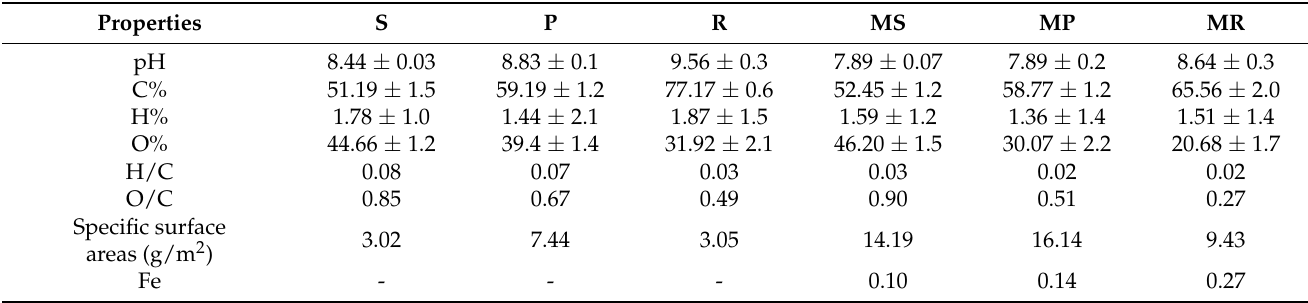
Table 1. Physicochemical properties of biochars before and after modification.